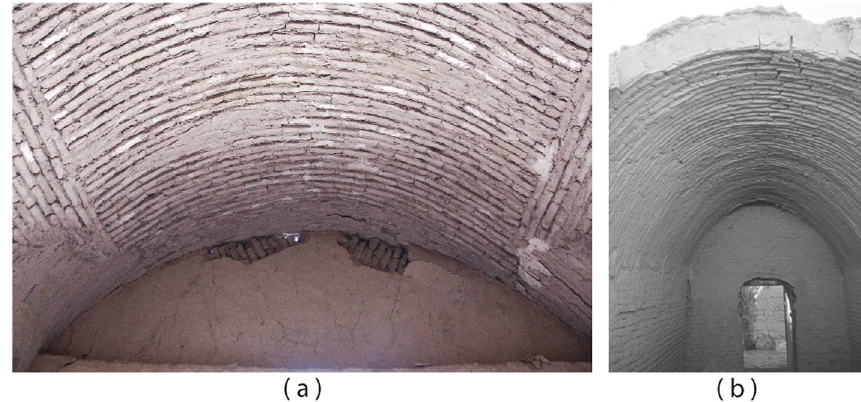
Fig. 15 Acceptable behaviour of curved roofs in the Bam earthquake: ( a ) an adobe vault built by the hybrid technique (Source: Maïni and Davis 2020) and ( b ) an adobe catenary vault built by the Par technique (Source: Minke